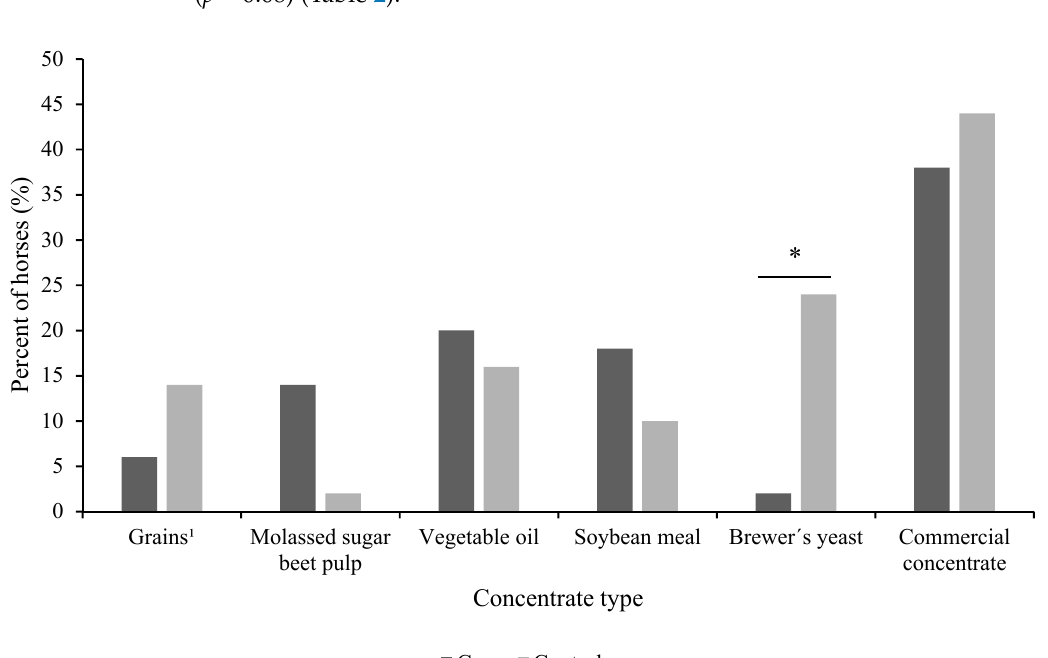
Figure 2. Proportion of horses with (case, n = 50) and without (control, n = 50) free faecal liquid fed different types of concentrate feeds. Multiple concentrates may have been fed to the same horse, resulting in a sum exceeding 100%. 1 Includes oats, barley and wheat bran. A higher proportion of control horses compared to case horses were fed brewer’s yeast ( p = 0.01). * = p < 0.05.